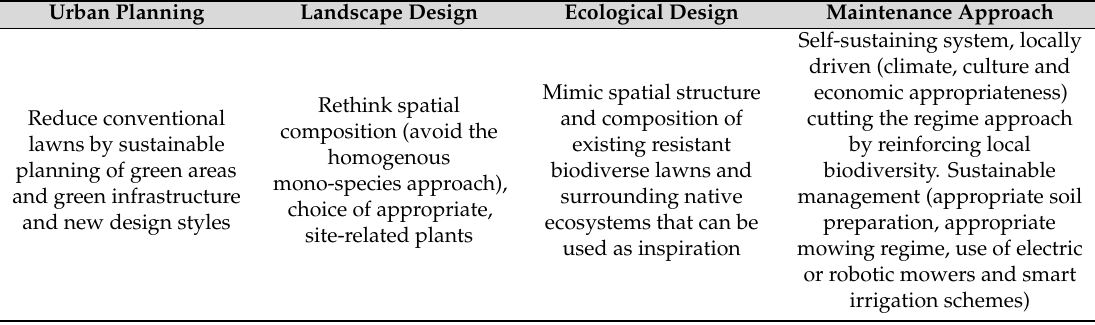
Table 4. Redesigning lawns, a complex approach towards sustainable